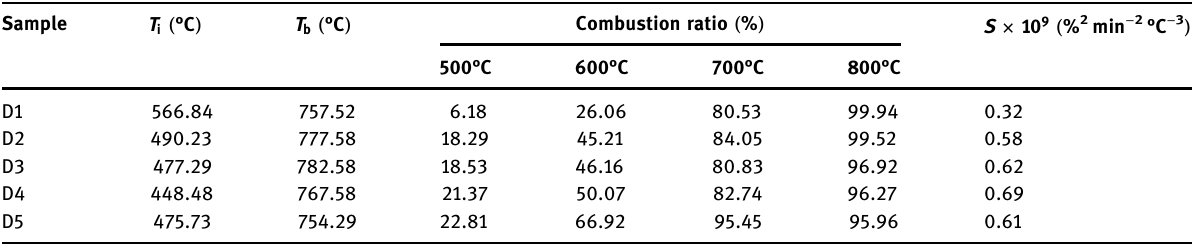
Table 2: Combustion parameters of mixed semi - coke samples Sample T i ( °C